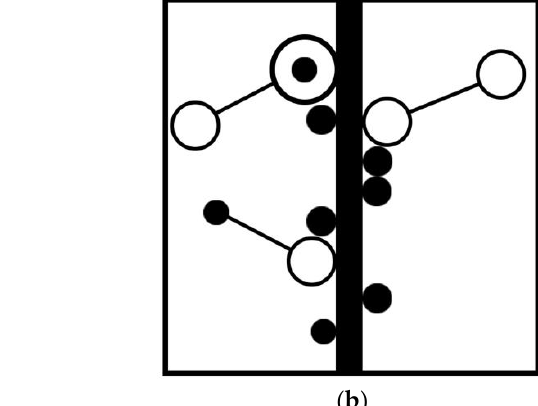
Figure 14. ( a ) Spatial pattern of the city network in the western GBM Delta. Source: the authors; Base Map: Google satellite map; Reference: [65]; ( b ) Belt Pattern Dominated by Industry and Com- merce. Source: the authors. The subregional city network in the eastern GBM Delta formed a decentralized pat- tern dominated by sociocultural factors. The eastern GBM Delta, which is linked to the Assam and Arakan areas, is characterized by a decentralized city network dominated by sociocultural factors. Due to the dominant terrain of flat and homogeneous alluvial plains